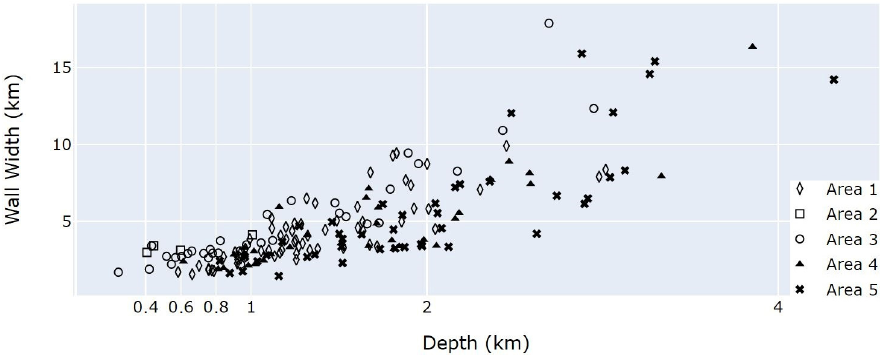
Figure 9. Wall width (Ww) versus depth of the freshest impact craters.